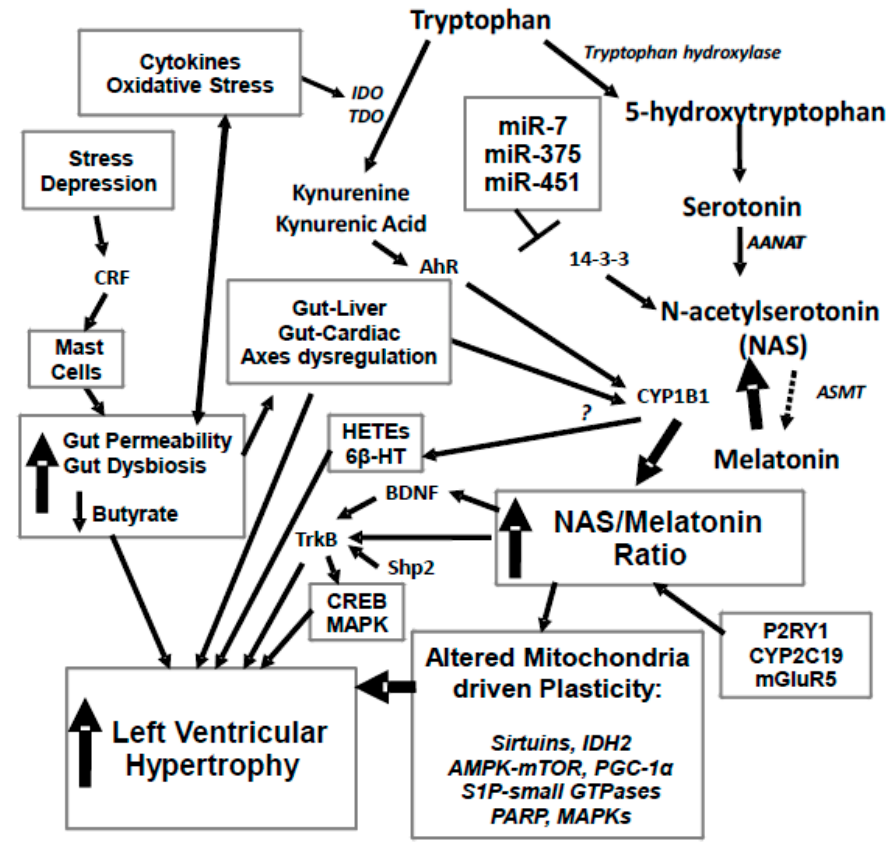
Figure 1. Stress and depression drive an increase in corticotropin releasing factor (CRF) that activates mucosal mast cells and leads to an increase in gut permeability, coupled to gut dysbiosis and decreased butyrate production. This drives alterations in the gut-liver and gut-cardiac axes, with a decrease in butyrate’s histone deacetylase (HDAC) inhibitory activity regulating CYP1B1. Increased gut permeability also drives an increase in oxidative stress and pro-inflammatory cytokines, which activate tryptophan 2,3-dioxygenase (TDO) and indoleamine 2,3-dioxygenase (IDO), leading to a driving of tryptophan down the kynurenine pathway, with a resultant decrease in serotonin, N-acetylserotonin (NAS) and melatonin synthesis. An increase in the NAS / melatonin ratio from CYP1B1 and probably mGluRgpI, P2Y1 receptor, CYP2C19 and O-demethylation leads to NAS activation of TrkB, as well as brain-derived neurotropic factor (BDNF) induction, in turn increasing cyclic adenosine 3 ′ ,5 ′‐ monophosphate (cAMP) ‐ response element binding protein (CREB) and the mitogen-activated protein kinase (MAPK) pathways, which all contribute to left ventricular hypertrophy (LVH). The suppression of melatonin drives alterations in mitochondria, including via melatonin’s interactions with the sirtuins and PGC-1 α , with consequences for IDH2 and AMPK-mTOR regulation of mitochondria. Alterations in the gut drive changes in the gut-liver and gut-cardiac axes that, along with kynurenine activation of the AhR raises CYP1B1 levels. CYP1B1 may also contribute to LVH via the hydroxyeicosatetraenoic acids (HETEs) and 6 β -HT. A number of microRNAs known to be altered in LVH, including miR-7, miR-375 and miR-451, all act to regulate 14-3-3 and therefore the stabilization of AANAT at the start of the melatonergic pathway. Similar processes can underpin hypertension, which is the major driver of LVH. 6 β‐ HT: 6 β‐ hydroxytestosterone; AANAT: aralkylamine N ‐ acetyltransferase; AhR; aryl hydrocarbon receptor; AMPK: AMP ‐ activated protein kinase; ASMT: acetylserotonin O ‐ methyltransferase; BDNF: brain derived neurotrophic factor; CREB: